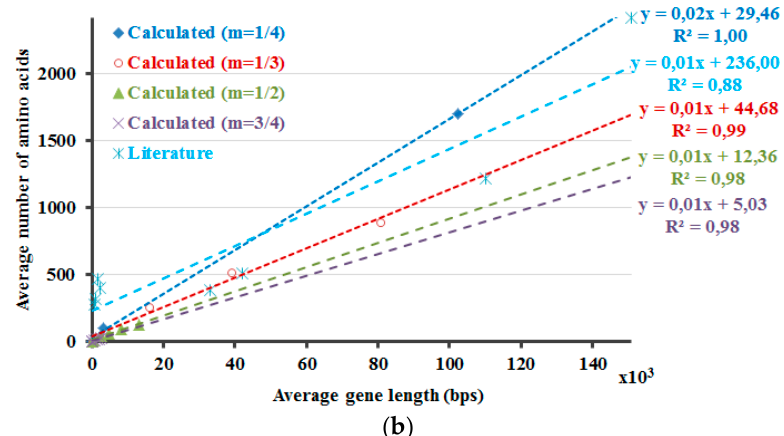
Figure 2. Average gene and protein sizes of distinct species that are reported in different sources are checked for their comparability with the calculated values. The calculated values’ data of these graphs is the DNA and the protein lengths that reveal the minimum non-negative values of the ∆ H results that are calculated through Equation (5). In line with the presented method, fitting of the data with exponential functions ( a ) leads as expected to very good results for the calculated data. However, this is not the case for the literature-based data. The situation improves for that literature-based data, through fitting the data with a linear function ( b ). The results of fitting the data with linear functions are plausible for the calculated data as well. For the data that is shown in ( b ), the least square fit analysis was performed for the closest result to the literature values according to the multiplier of the x-parameter in the linear-fit function, and the slope of the data were not statistically different at the 0.05 significance